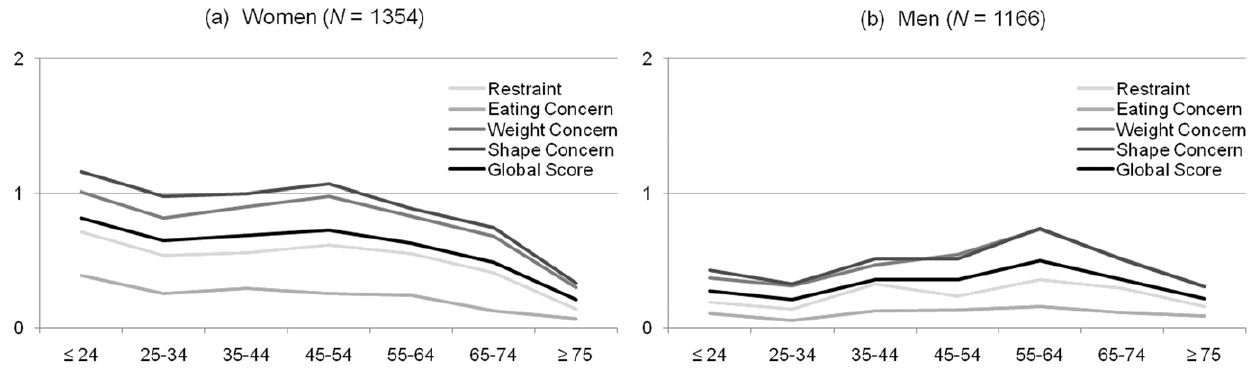
Figure 1. Subscale Scores and Global Scores of the Eating Disorder Examination-Questionnaire Across the Age Range (N=2520). Notes . Scores ranging from 0= feature was absent to 6= feature was present every day or to an extreme degree . Higher values indicate greater psychopathology. Post-hoc analyses women: Restraint (RS), Weight Concern (WC), Shape Concern (SC), Global Score (GS) ages $ 75 lower than all other ages; Eating Concern (EC) age $ 75 lower than age # 24 and 35–44, and age 65–74 lower than age # 24; WC and GS age 65–74 lower than age # 24 (all p , .01). Post-hoc analyses men: WC, SC, and GS age 55–64 greater than age # 24, 25–34, and $ 75 (all p , .01).